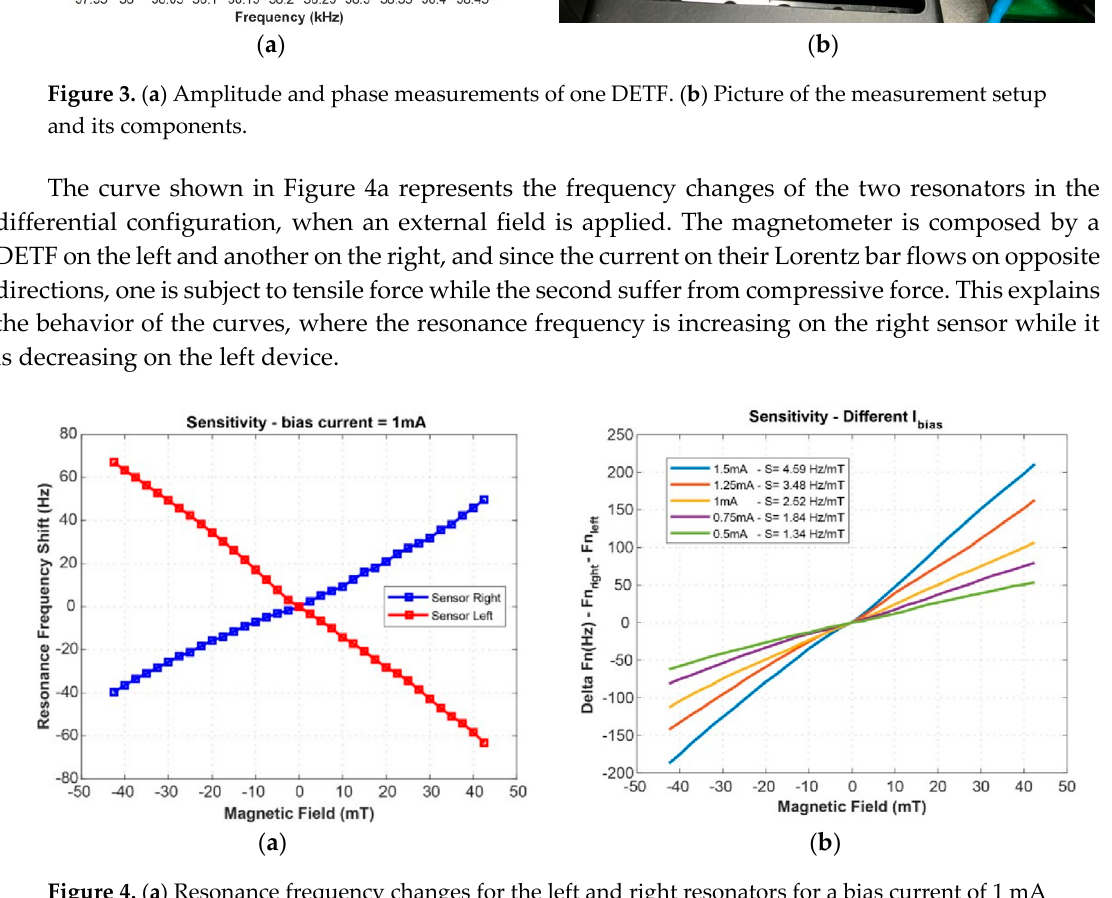
Figure 4. ( a ) Resonance frequency changes for the left and right resonators for a bias current of 1 mA and ( b ) sensitivity of the frequency modulate sensor for different bias